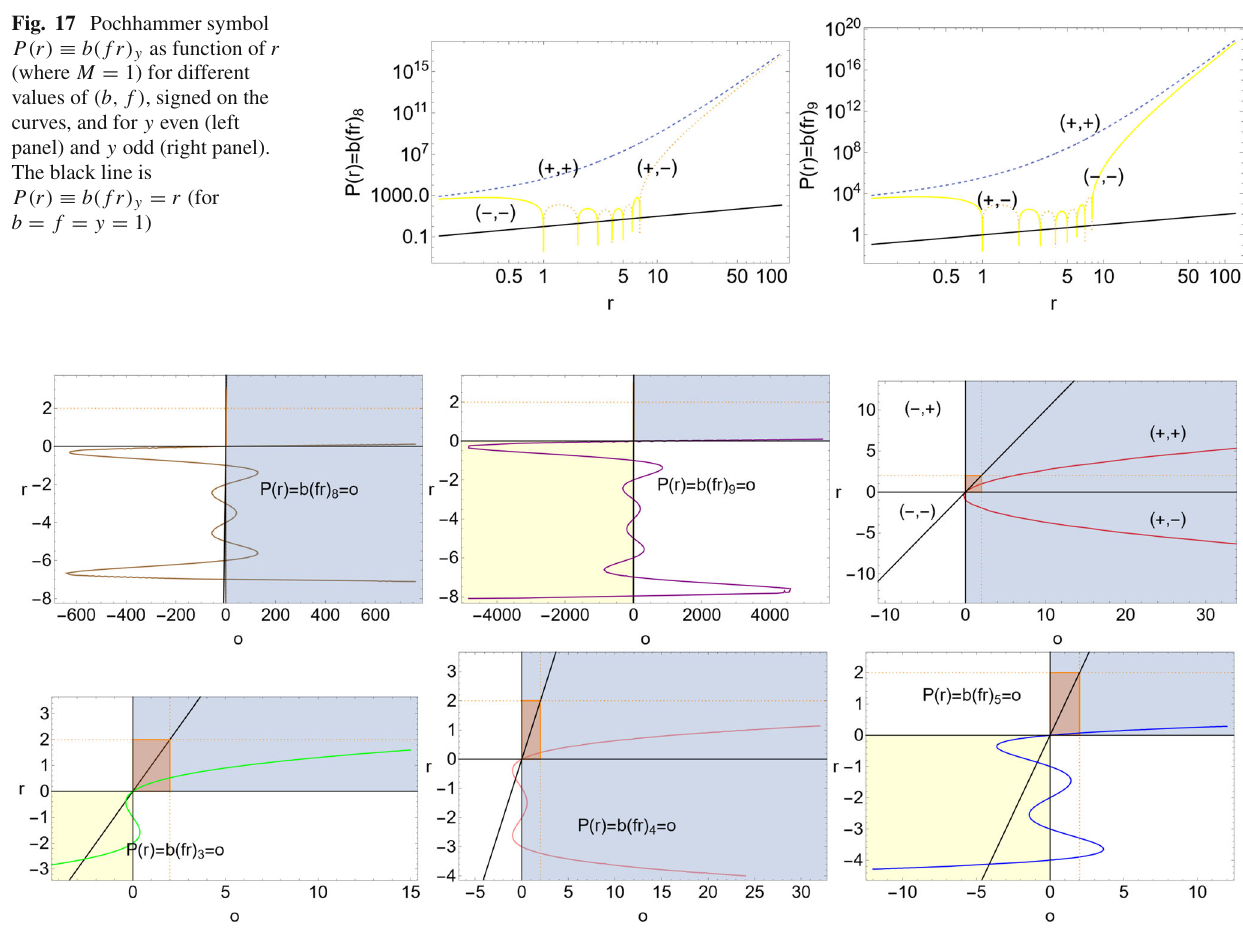
Fig. 18 Pochhammer symbol P ( r ) ≡ b ( f r ) y = o in the plane r − o for different values of y , signed on the panels, where { b , f } = ± 1. For y = (odd, even) different regions of the parameters ( b , f ) = ± 1 are signed as the ( o , r ) regions, respectively. The zeros o = 0 are shown.